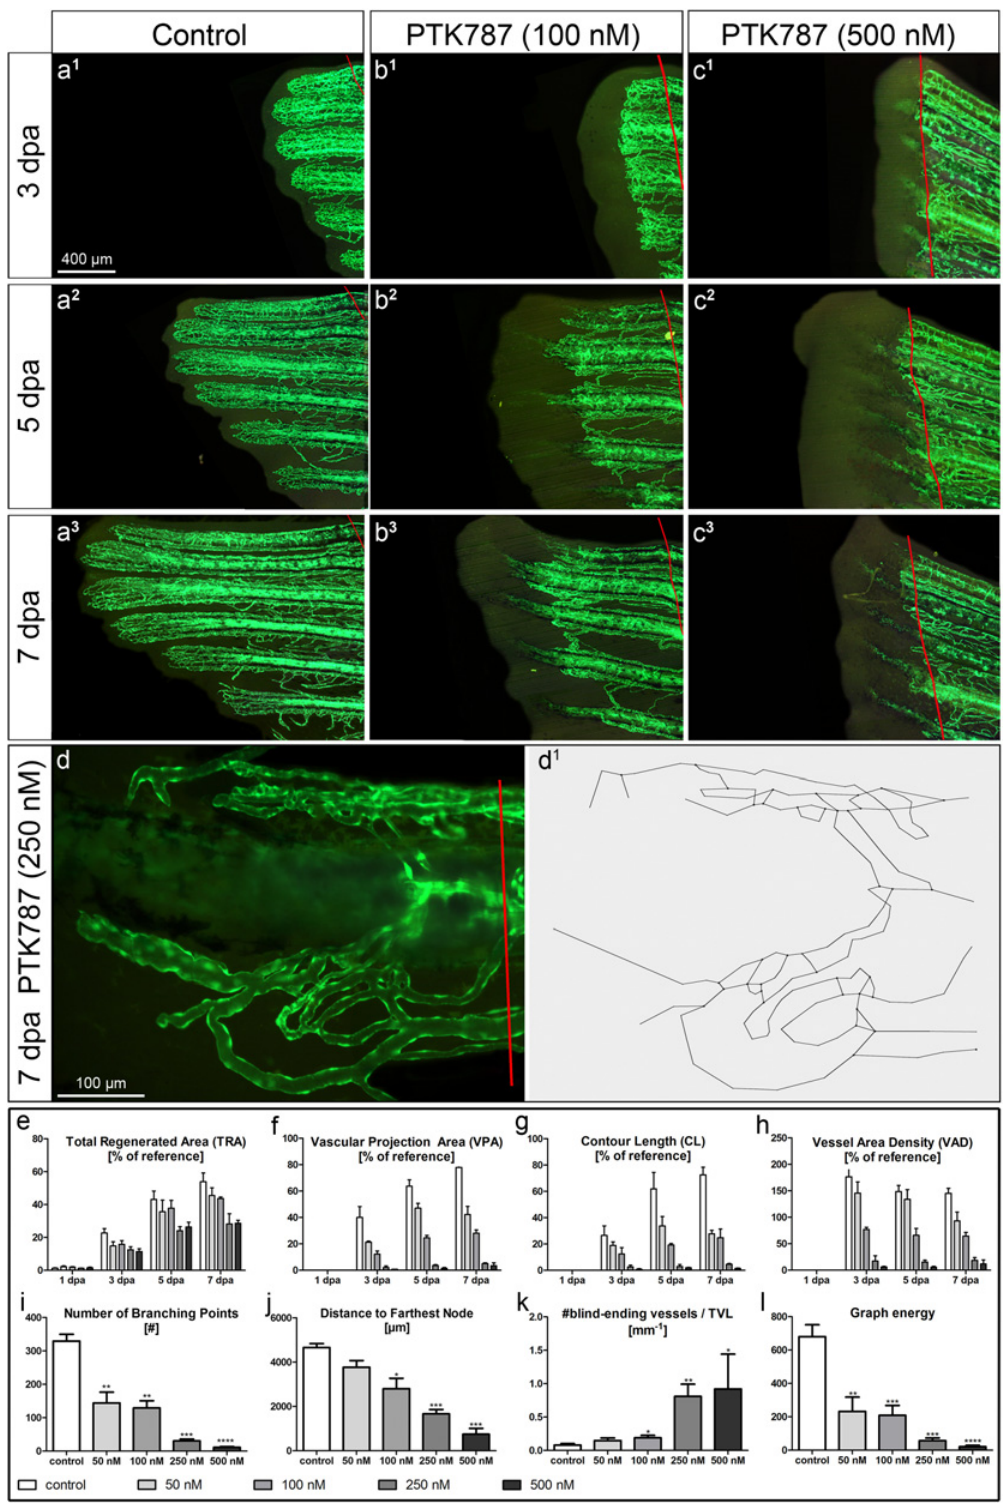
Fig 4. DAA: Assessment of the anti-angiogenic effects of PTK787 at different concentrations 50, 100, 250, 500 nM: a-c Fluorescent images of regenerating caudal fins at 3 ( a 1 -c 1 ), 5 ( a 2 -c 2 ) and 7 dpa ( a 3 -c 3 ) under 3 different conditions: vehicle control (left column), 100 nM (middle) and 500 nM PTK787 (right column). PTK787 clearly inhibits regenerative vascular outgrowth in a dose-dependent manner as confirmed by the quantitative assessment